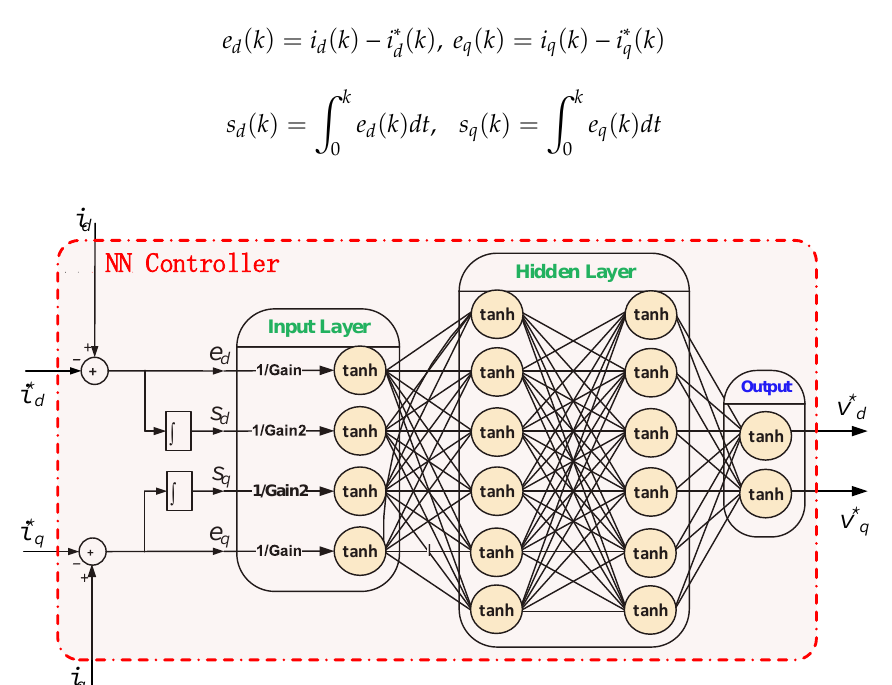
Figure 3. Structure of the neural network (NN) controller.